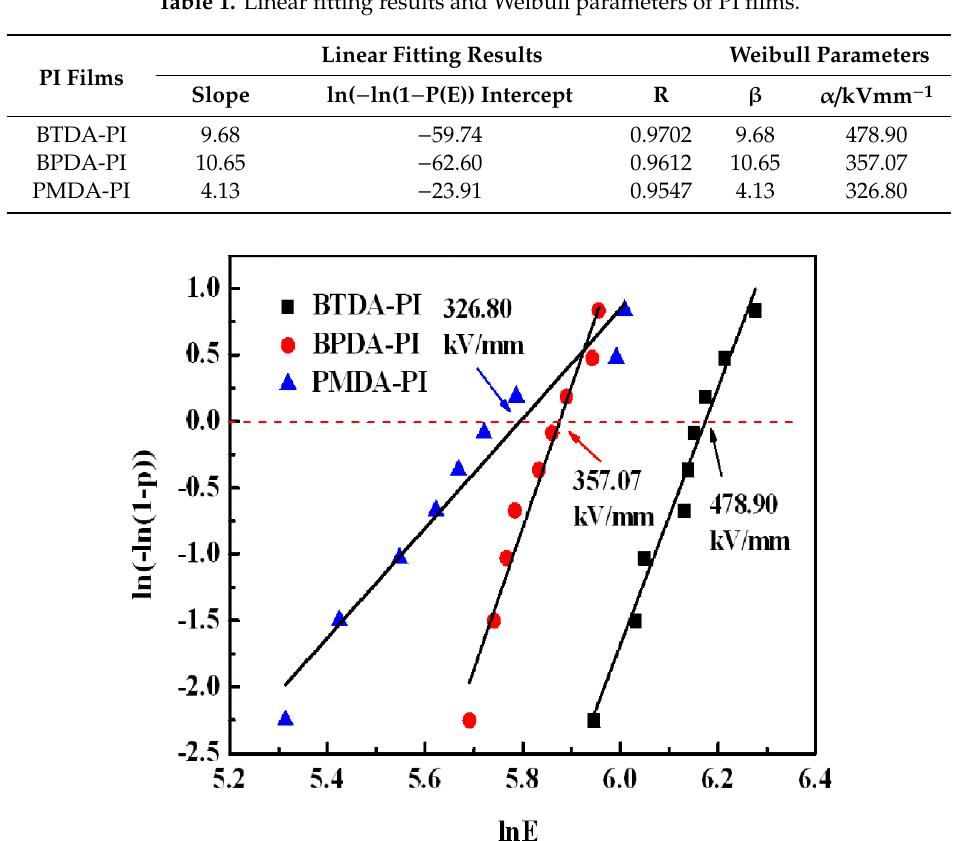
Figure 5. Weibull distribution of PI films.